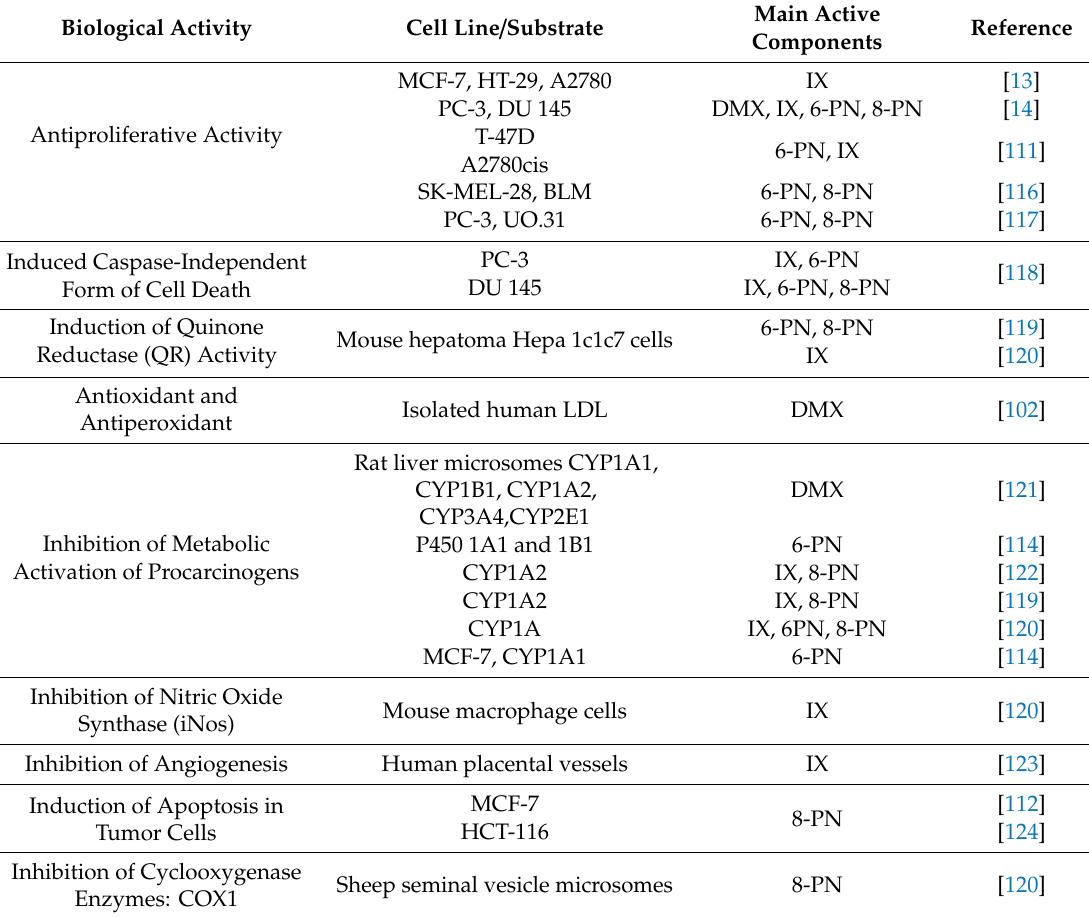
Table 2. In vitro activity of phytoestrogens and their precursors as potential anticancer agents. Biological